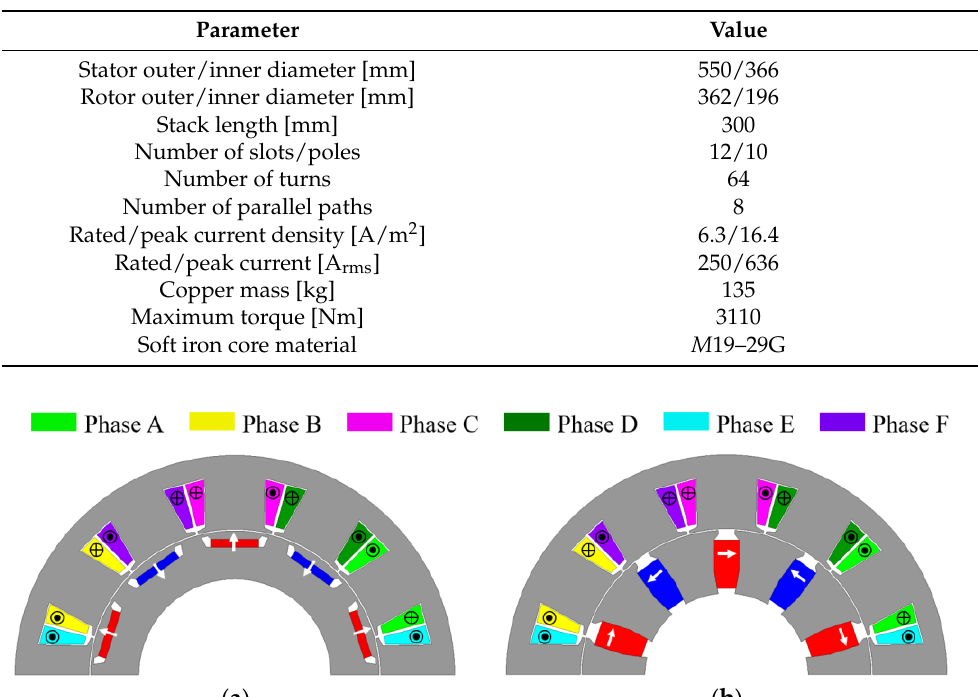
Table 1. Specifications of benchmark motor. Data from [3].